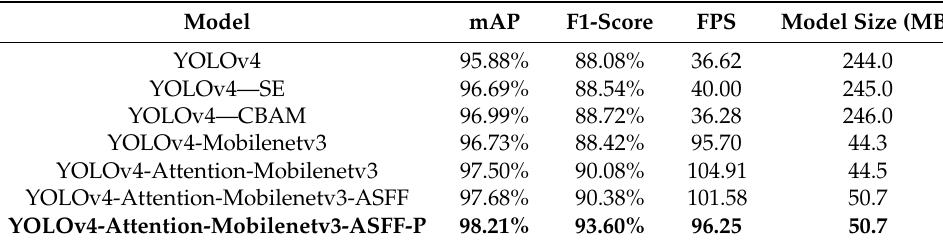
Table 2. The results of fruit tree detection based on different